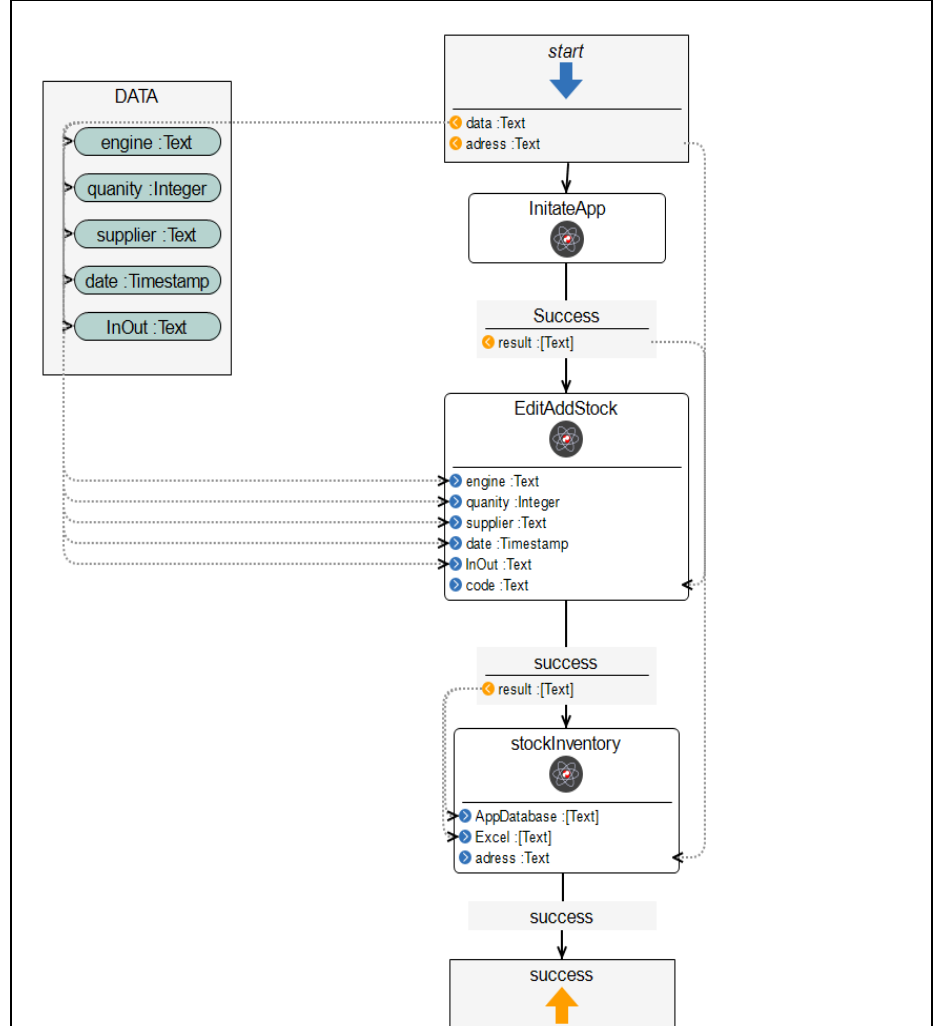
Fig 7. Subprocesses of the application for entering